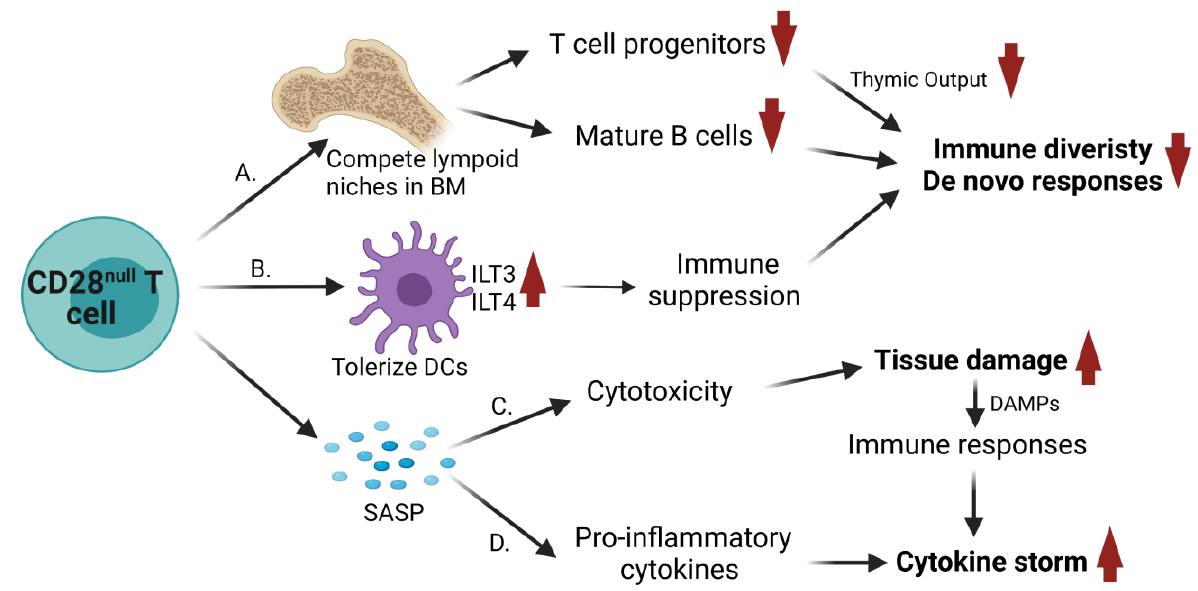
Figure 2. Molecular and cellular basis whereby CD28 null senescent T-cells lead to adverse outcomes. (A) CD28 null senescent T-cells resist to apoptosis and migrate to bone marrow (BM), where they compete in limited lymphoid niches, which leads to decreased output of mature B cells and T-cell progenitors. A decrease in T-cell progenitors further results in thymic dystrophy and impaired T-cell development. Decreases in B and T-cell replenishment lead to narrowed antigenic diversity. (B) CD28 null senescent T-cells interact with dendritic cells (DCs) and tolerize DCs by induction of high levels of inhibitory receptors, ILT3 and ILT4, and repression of CD28/CTLA4 ligands, CD80 and CD86, contributing to immune suppression. (C-D) CD28 null senescent T-cells possess a SASP. (C) After receiving stimuli from alternative costimulatory molecules, OX40 and 4-1BB, and NK-like receptors, CD28 null cells actively express cytotoxic mediators, perforin and granzymes, which mediate unrestricted tissue damage and release of damage-associated molecular patterns (DAMPs). DAMPs enhance immune responses. (D) CD28 null cells also produce pro-inflammatory cytokines, such as IL-6, IL-17, TNFα, and IFNγ, contributing to worsening cytokine release syndrome (“cytokine storm”) in infectious diseases, such as COVID-19.